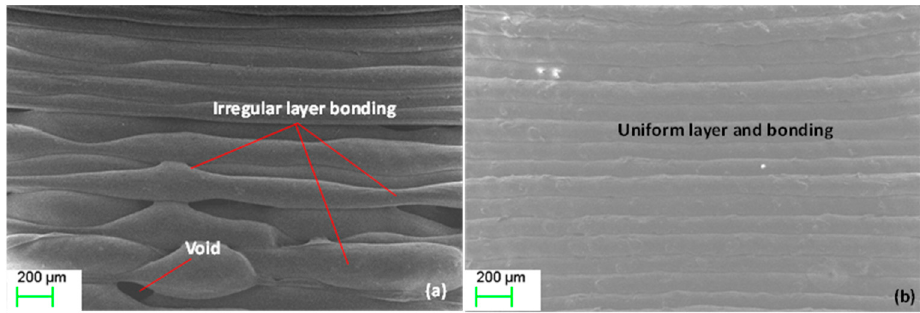
Figure 8. Benchmark print models for: ( a ) OTS; ( b ) waste; ( c ) 2% Mg; ( d ) 4% Mg; ( e ) 8% Mg.